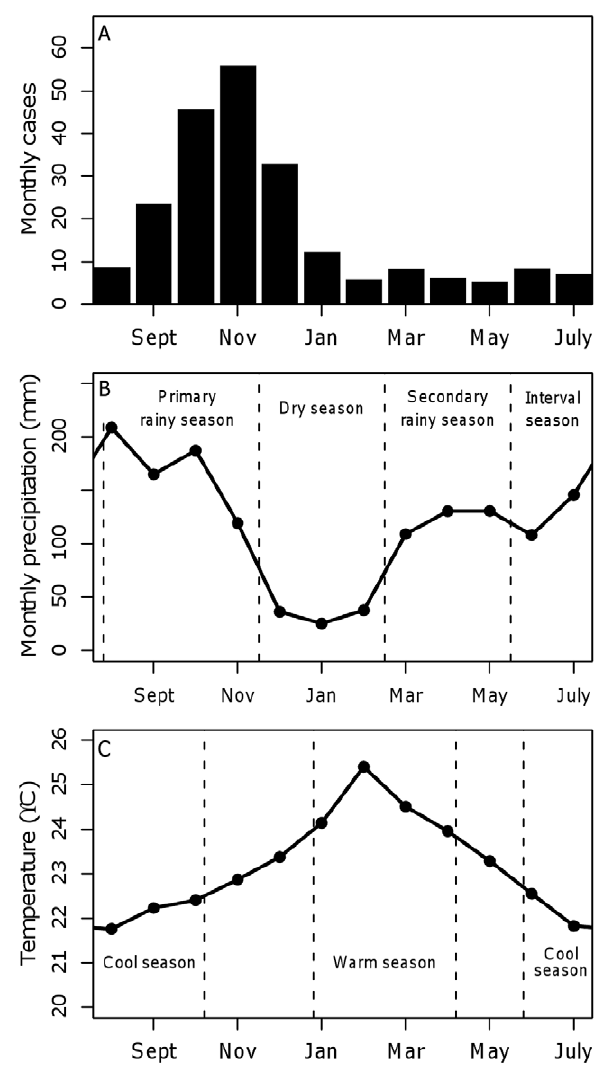
Figure 2. Seasonal patterns of suspect plague cases, temper- ature, and rainfall. Average monthly (A) number of suspect plague cases, (B) rainfall, and (C) mean temperature in Vurra and Zombo counties, Uganda for 1999–2010. Data are organized by plague year which runs from August to July. Temperature data are averages of monthly means from the Arua airport observational dataset and the ERA-Interim dataset. The warm season is from January to April and the cool season is from June to October. Rainfall data are average monthly rainfall totals from the CMORPH, TRMM, FEWS-Net, and the Arua airport observational datasets. (See text for further details regarding the meteorological datasets and seasonal descriptions).